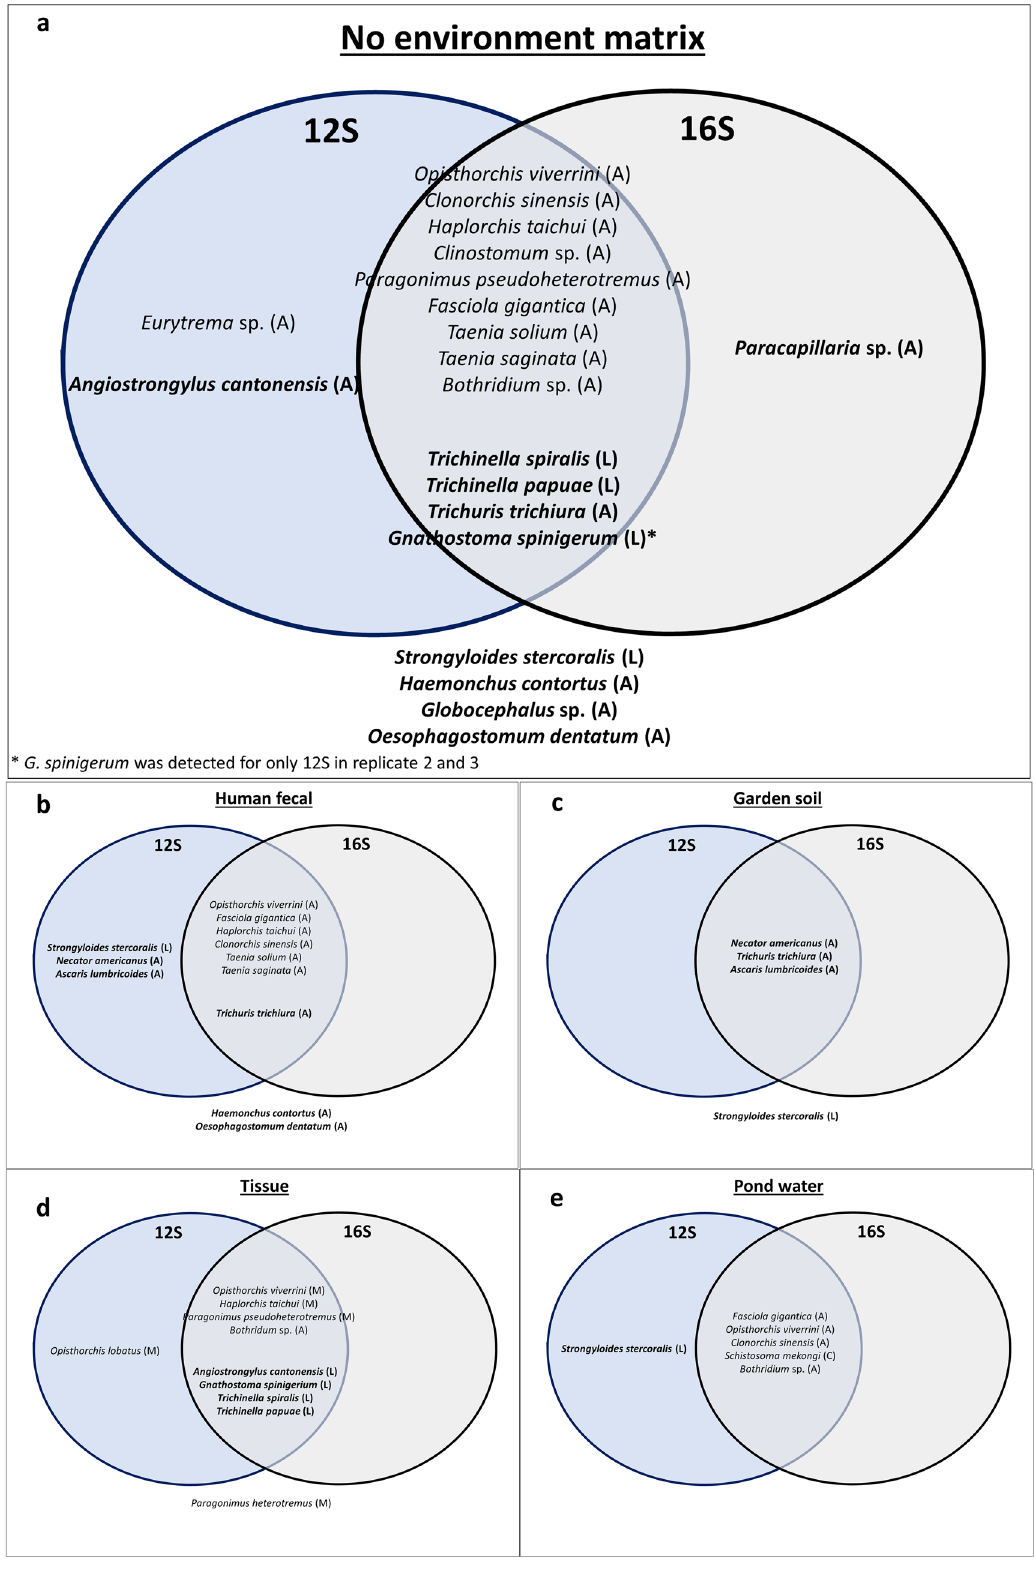
Figure 1. Venn diagram of helminth species recovered in the mock communities—( a ) no environment matrix, ( b ) human fecal, ( c ) garden soil, ( d ) tissue, and ( e ) pond water after DNA metabarcoding using the mitochondrial 12S and 16S rRNA genes. Species recovered using both genetic markers are in the overlap region, while species not detected by either marker are outside of the Venn diagram. Nematodes are indicated in bold text, while platyhelminths are not in bold